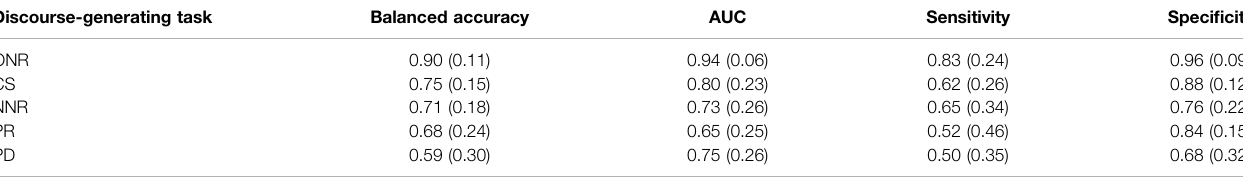
TABLE 6 | HC vs. AD mean (s.d) SVM classi fi cation performance across fi ve-fold cross-validation for fi ve connected speech tasks, ranked by accuracy. Discourse-generating task Balanced accuracy AUC Sensitivity Speci fi city